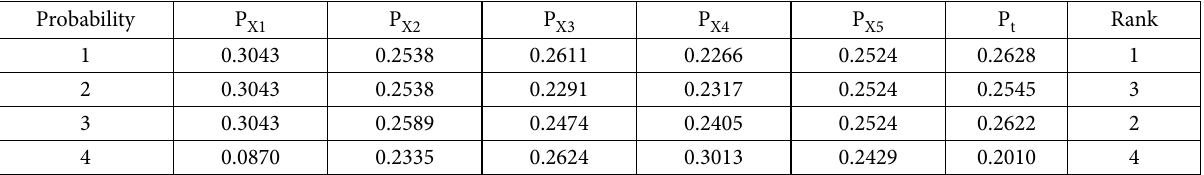
Table 3. Evaluated results for partial favorable probability, total favorable probability and ranking